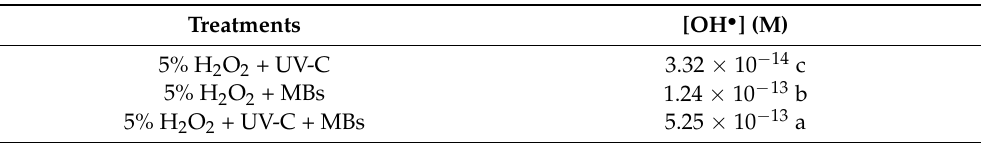
Means with different letters are significantly different at p ≤ 0.05 by LSD